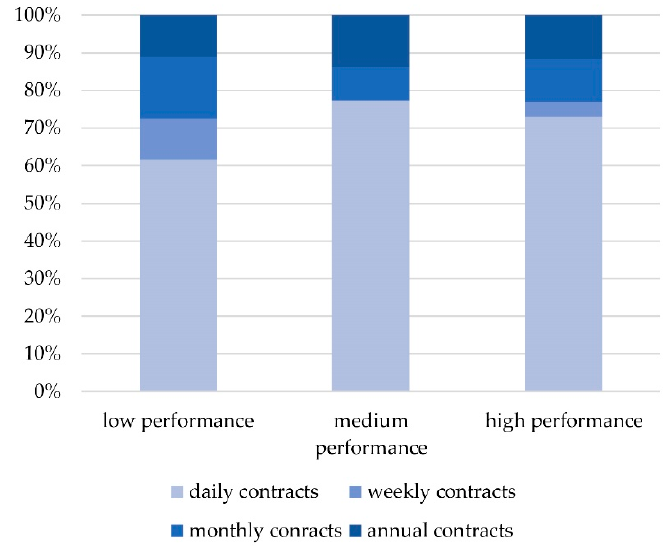
Figure 11. Costliest contracts by performance category.